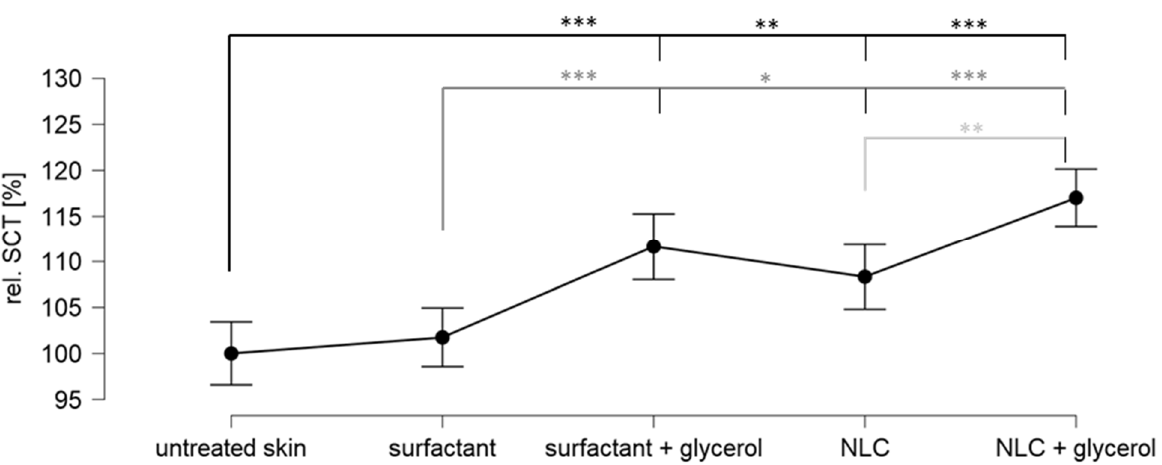
Figure 9. Relative stratum corneum thickness of skin treated with sodium fluorescein in surfactant solution with and without NLC particles and with and without glycerol. The asterisks indicate the following p -values: * ≤ 0.05; ** ≤ 0.01; *** ≤ 0.001.